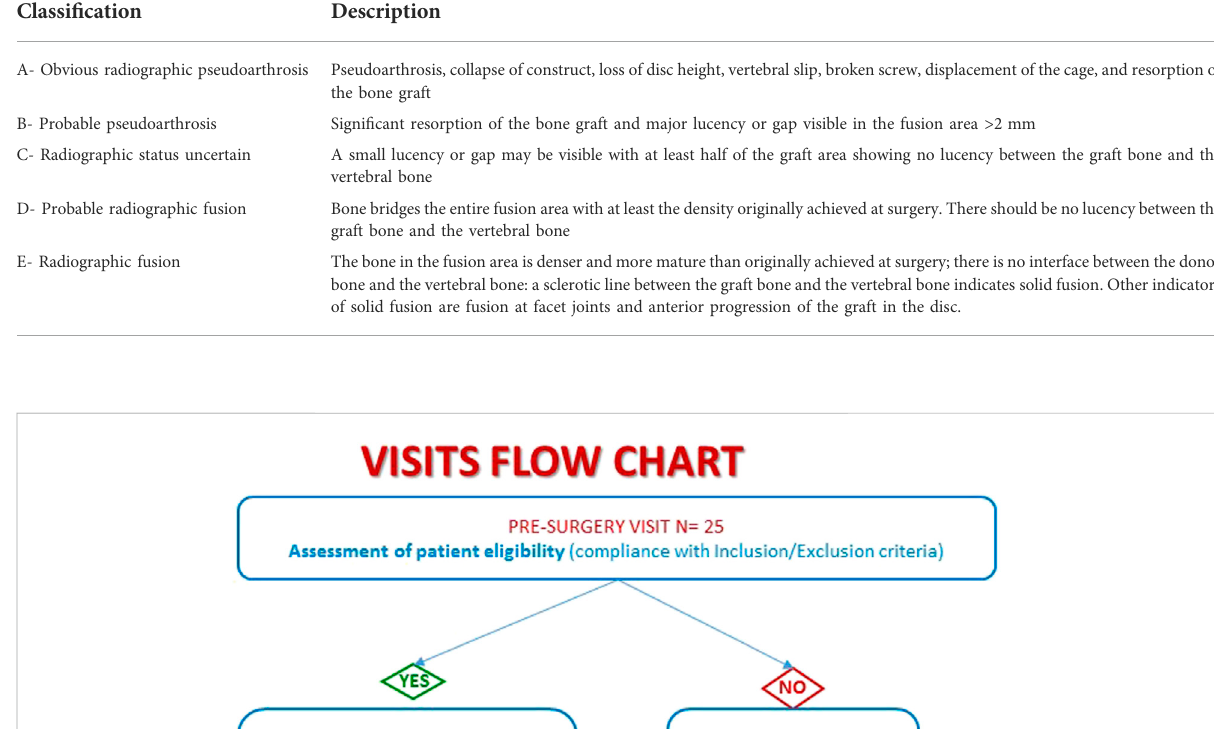
TABLE 1 Brantigan classi fi cation of spinal fusion.